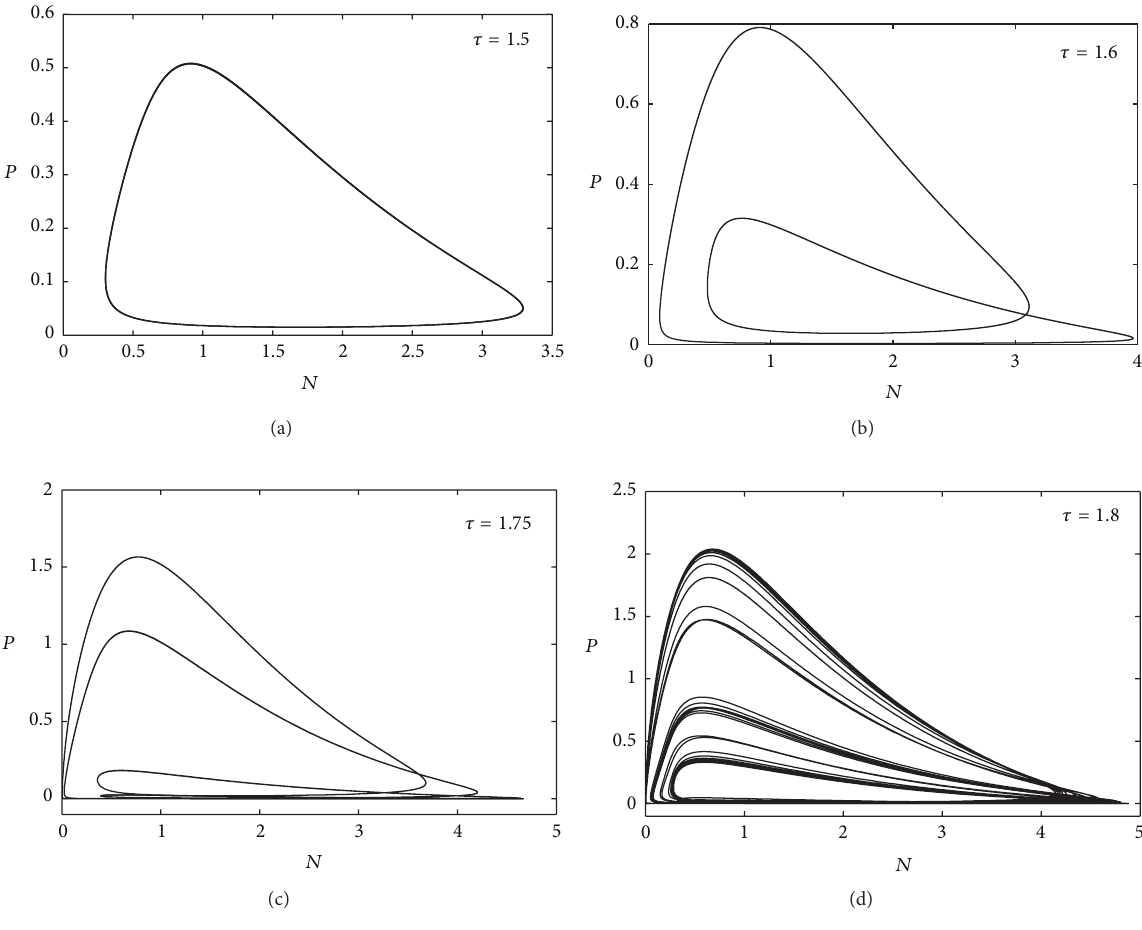
Figure 2: Bifurcation of model (84) with bifurcation parameter 𝜏